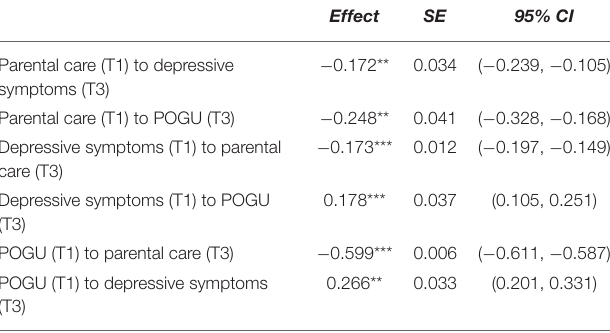
TABLE 4 | Indirect effects of parental care, depressive symptoms, and POGU. Effect SE 95%